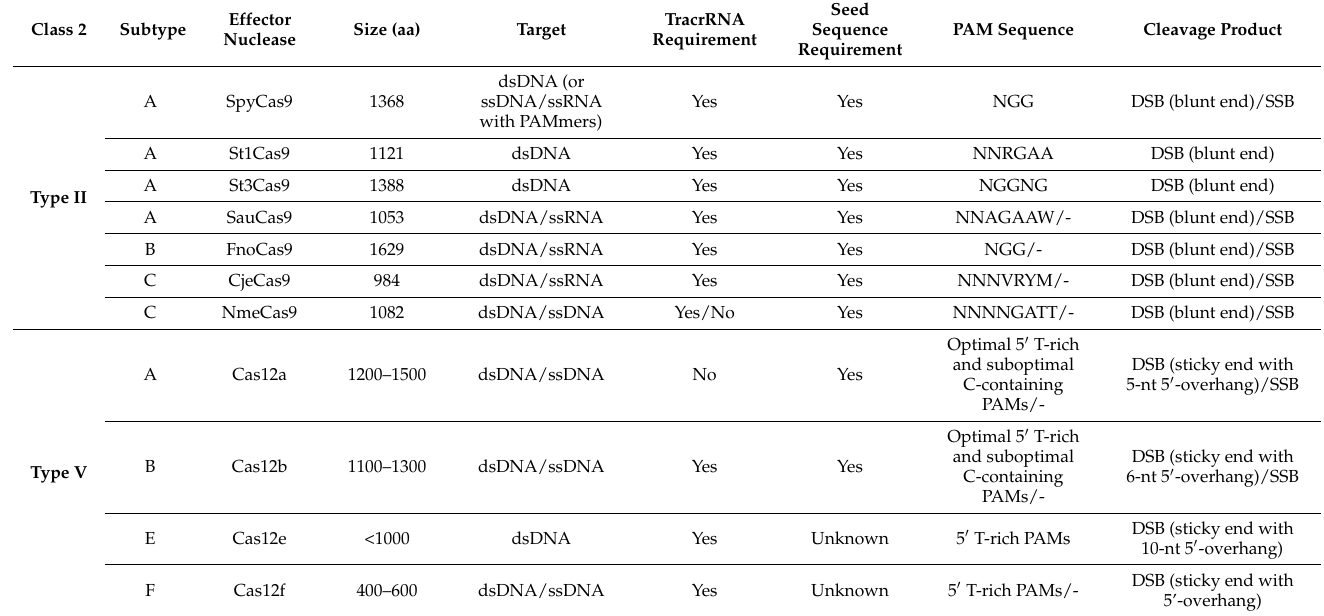
Figure 1. Schematic illustration of DNA recognition and cleavage by CRISPR-SpyCas9. ( A ) RNA duplex is loaded onto SpyCas9 to form ribonucleoprotein (RNP). ( B ) The PAM-interacting (PI) domain of the NUC lobe recognises 5′-NGG-3′ PAM and facilitates the binding of crRNA to the target DNA to form R-loop. ( C ) The REC3 domain of the REC lobe and Bridge helix (BH) sense mismatches. ( D ) The REC2 domain of the REC lobe undergoes a large outward rotation, leading to the conformational transition of the HNH domain into an active state. The HNH and RuvC domain of the NUC lobe then cleaves the target and non-target strands of the target DNA, respectively. The cleavage site is always located at 3- to 4-nt upstream of PAM. Created with BioRender.com. Aside from the canonical SpyCas9 from Streptococcus pyogenes , many other Cas9 orthologs and the type V CRISPR-Cas12 systems have been uncovered and used for mam- malian genome editing, as summarised in Table 1 [16,26–40]. Table 1. Summary of CRISPR-Cas systems used for genome editing of mammalian cells.